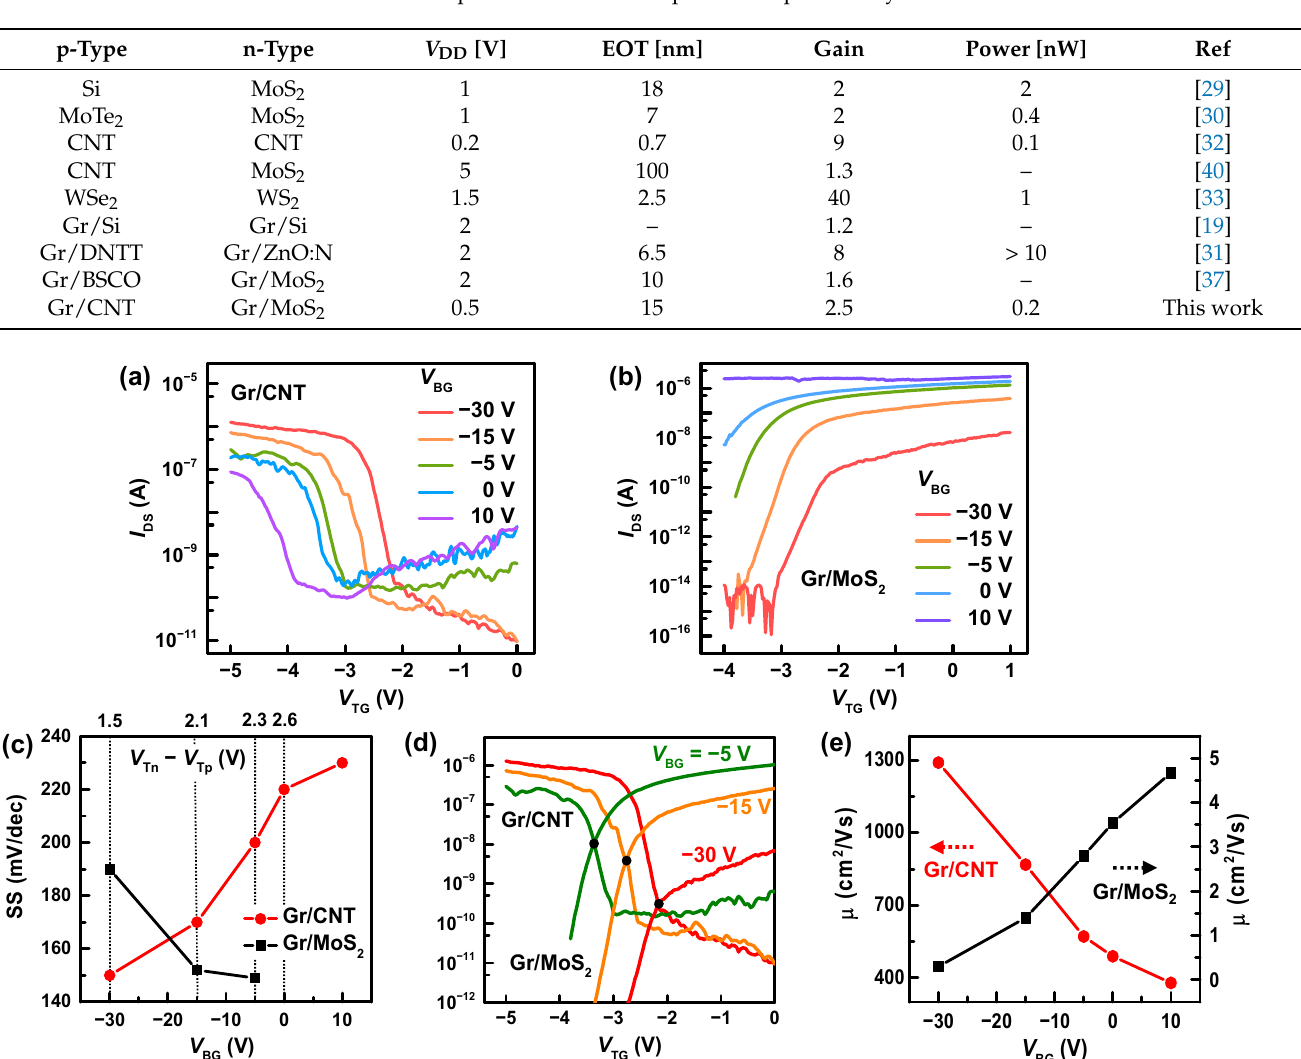
Table 1. Comparison between low-power complementary inverters.